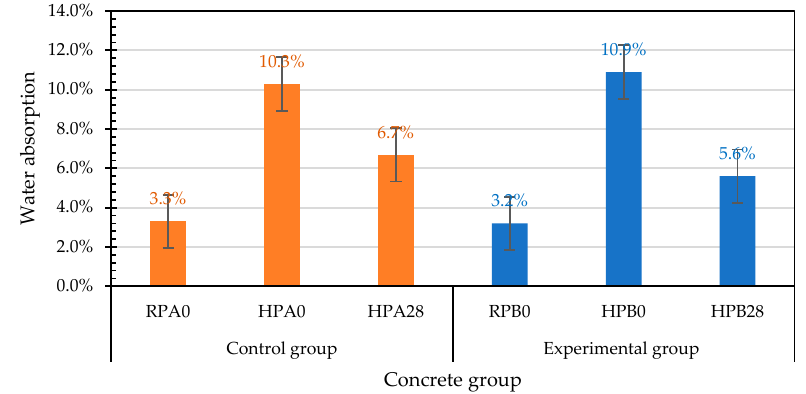
Figure 27. Effects of different test parameters on water absorption of concrete.